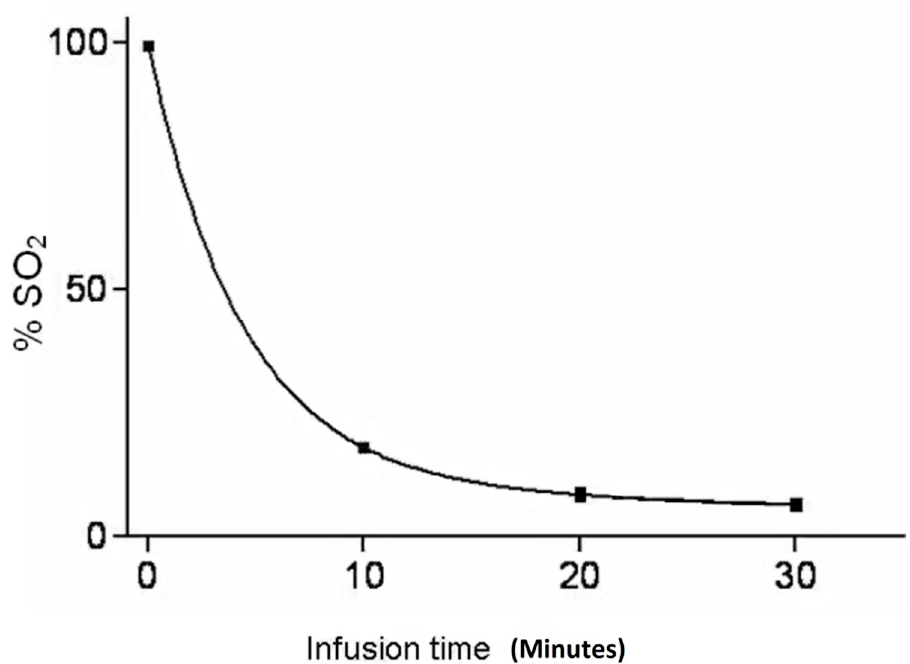
Figure 5. Typical saturation graph of the perfusate during isolated limb